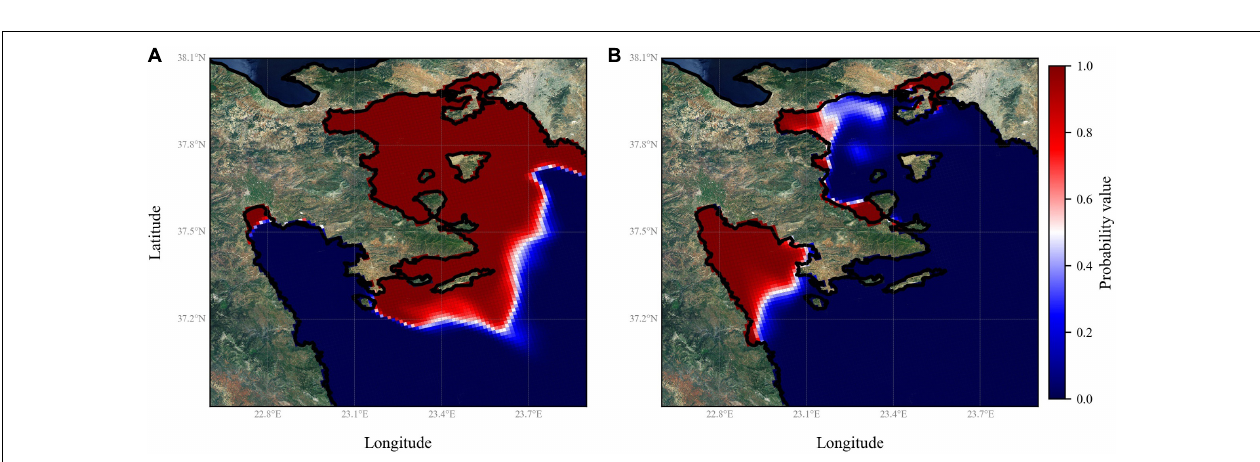
FIGURE 7 | Ensemble spread of SWT simulation for (A) Ortholithi (B) Ovrios together with observations and deterministic simulation.